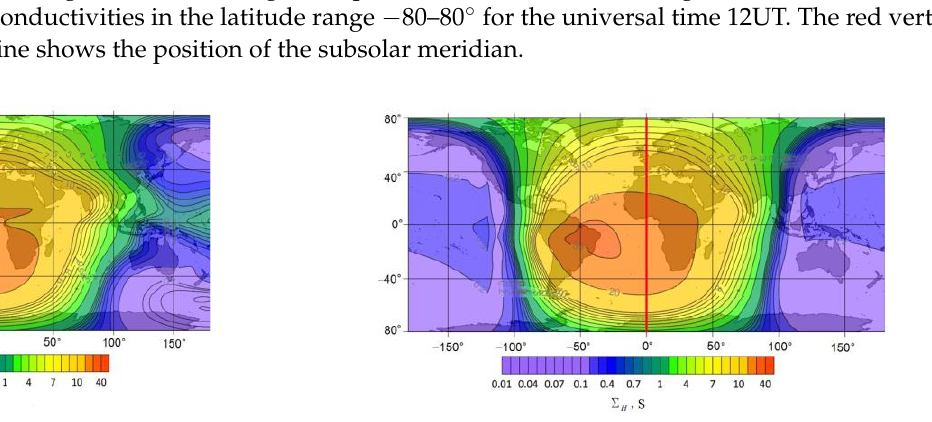
Figure 3. An example of the spatial distribution of the integrated Pedersen ( left panel) and Hall ( right panel) conductivities. The red vertical line shows the position of the subsolar meridian.